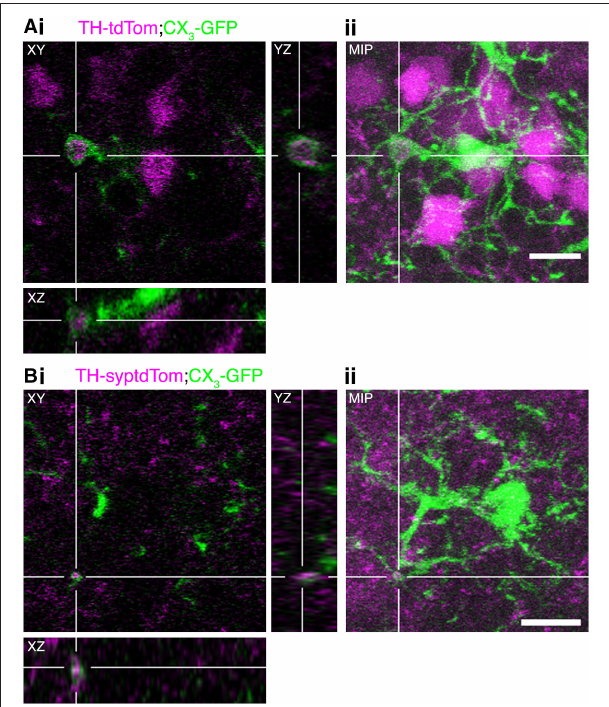
FIGURE 7 | Microglia engulf components of DA neurons in the occluded OB. (A,B) Examples of microglial engulfment of tdTom-labeled material in the occluded OB of (A) a TH-tdTom;CX 3 -GFP mouse and (B) a TH-syptdTom;CX 3 -GFP mouse. (i) 3D section views. (ii) Maximum intensity projection. All scale bars: 10 µ